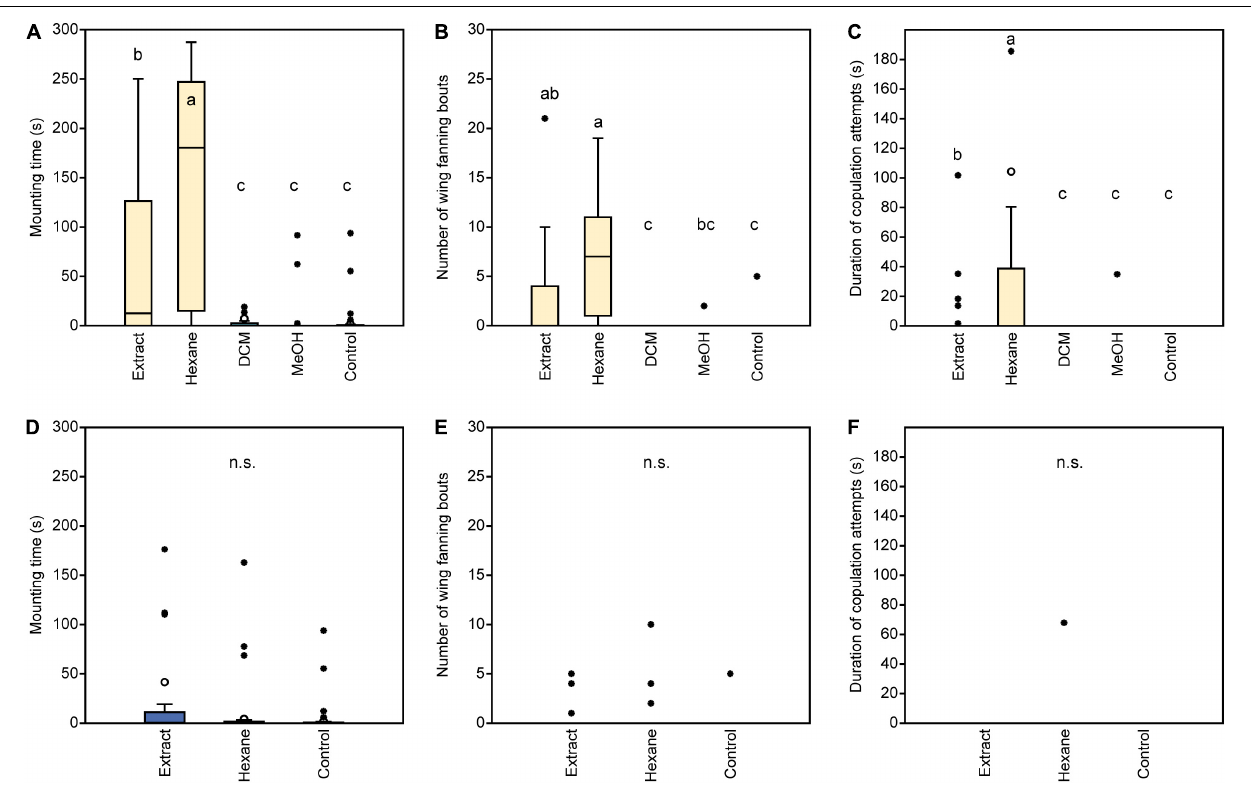
FIGURE 3 | Behavioral responses of U. rufipes males to Soxhlet-extracted male dummies treated with female- (A–C) or male-derived (D–F) whole body extracts and fractions thereof obtained by silica gel chromatography using hexane, dichloromethane (DCM), or methanol (MeOH) as eluents. Control dummies were treated with the pure solvent. Given are (A,D) the time males spent mounted on the dummy, (B,E) the number of wing-fanning bouts, and (C,F) the duration of copulation attempts. Box-and-whisker plots show median (horizontal line), 25–75% quartiles (box), maximum/minimum range (whiskers) and outliers ( ◦ > 1.5 × box height; • > 3 × box height). Different lowercase letters indicate significant differences between treatments for each parameter at p < 0.05 (Kruskal-Wallis H -test followed by multiple Mann-Whitney U -tests with sequential Bonferroni-correction; n.s. = non-significant; n = 25). Statistical results are given in detail in